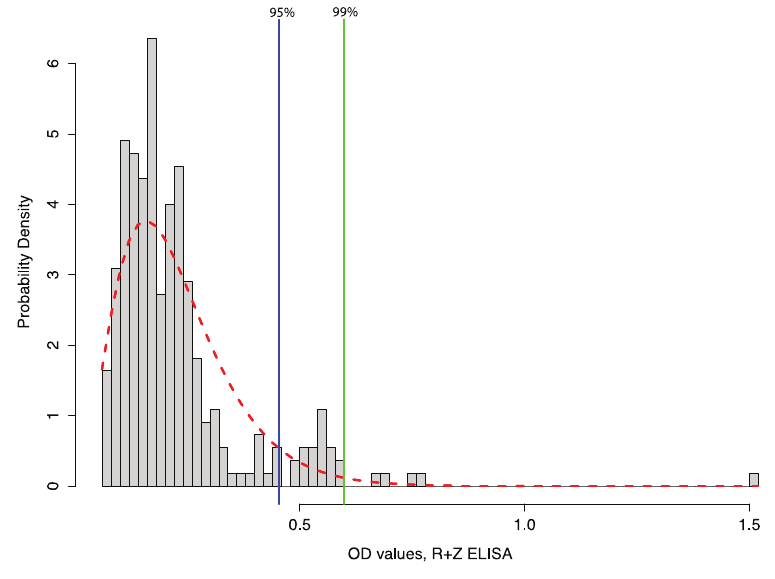
1:1 mixture of recombinant nucleoproteins for Reston + Zaire (R+Z) ebolavirus in Rousettus leschenautlii fruit bats. Data from [63], using methodology adapted from [77]. Cut-off values were determined to be >0.454 for the R+Z ELISA using a maximum likelihood estimator, gamma distribution, and 95% risk of error. Pourrut et al. 2009 used an exponential distribution, but the data here are better fitted to a gamma distribution. This approach is less arbitrary than the standard approach of using a value 3× the OD value of negative control, as it uses the distribution of the data itself and a statistical framework to identify potential positive cut-off values. Grey bars = OD values from individual bats for the R+Z ELISA (without positive or negative controls); red line = gamma distribution; blue = 95% confidence of cutoff values; green = 99% confidence. After initial screening, 15 (11%) of 141 R. leschenaultii , 6 (8%) of 75 Cynopterus spp., and 4 (7%) of 56 Megaderma lyra bats were potentially positive at the 95% confidence level. However, only 5 (3.5%) of 141 (95% CI 1.5%–8.0%) of R. leschenaultii bats were reported as seropositive after additional testing by ELISAs and Western Blot